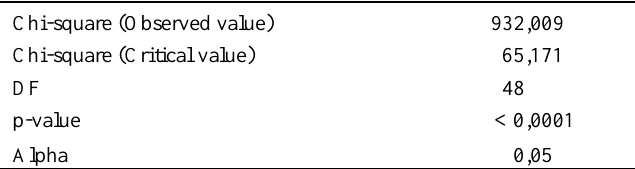
Table 2: Test of independence between the rows and the